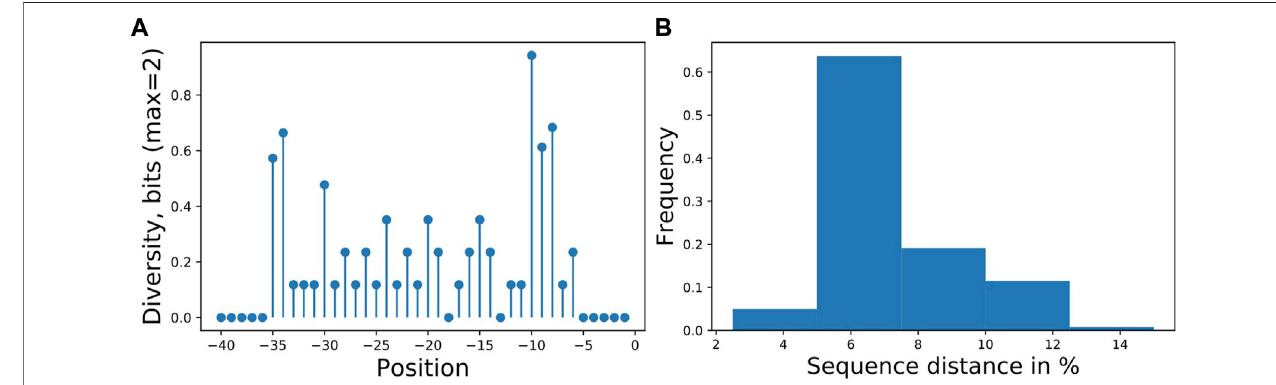
FIGURE 2 | (A) Promoter sampling diversity of the complete data set for nucleotide variations on each sequence position, transcription starts at 0 and (B) mutual sequence distances. The promoter library is based on our previously published library (Köbbing et al., 2020), with additional sequences totaling 63 different promoters with mutations directly upstream of the transcription start site. Two positions ( − 13, − 18) were not mutated resulting in 28 tested positions.